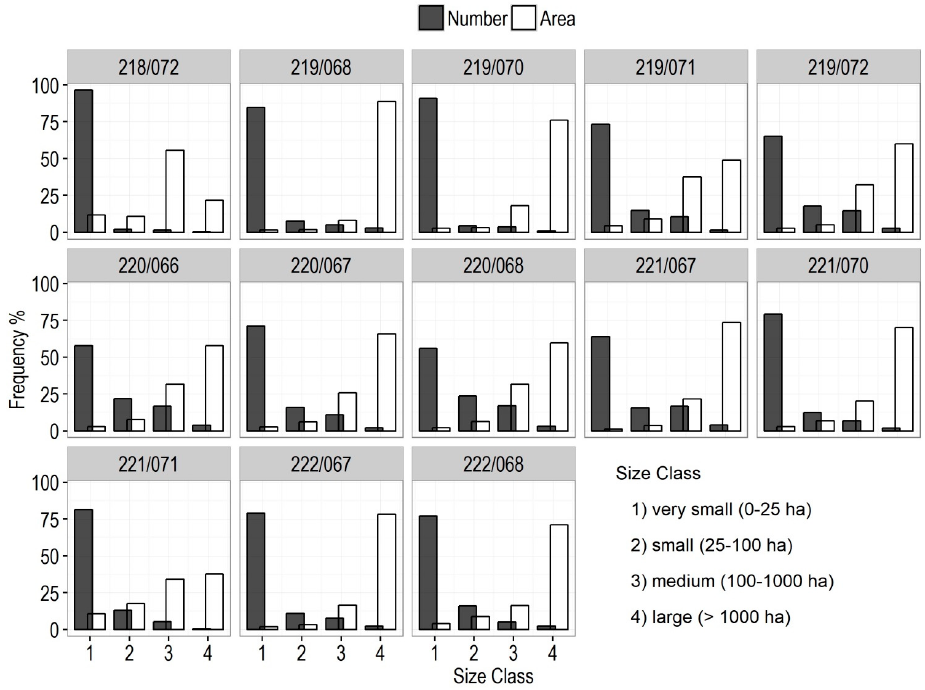
Figure 6. Distribution of reference fire scars by number (gray bars) and by area (white bars) according to each size class (1) very small (0–25 ha); (2) small (25–100 ha); (3) medium (100–1000 ha) and (4) large (>1000 ha), for each Landsat 8 scene.